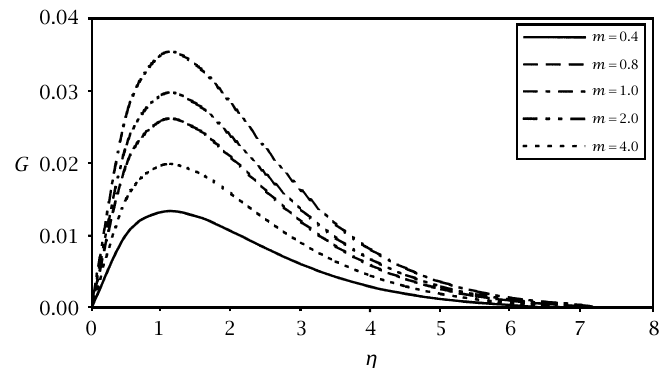
Figure 3.5 . The variation of G against η for M = 0 . 2 and R = 1.